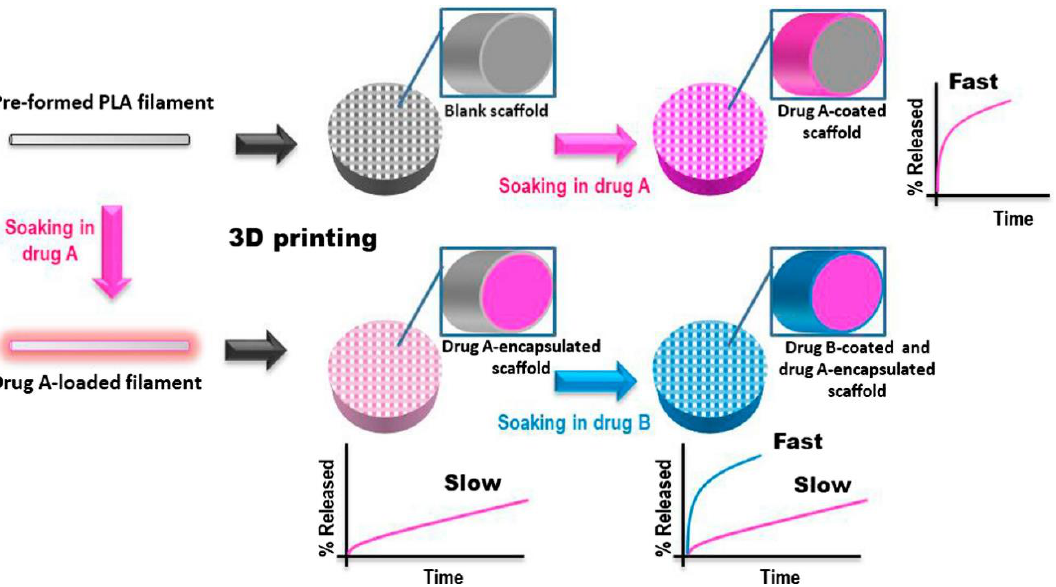
Figure 12. Drug loading by soaking of either preformed PLA filaments or 3D printed scaffolds. Reprinted with permission from reference [134]; copyright (2019) Elsevier B.V.